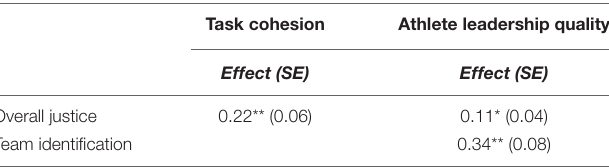
TABLE 2 | Standardized indirect effects and standard errors (SE) for all paths in the model between predictors (in rows) and outcomes (in